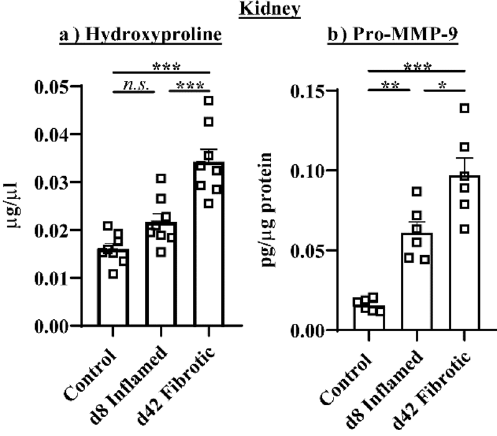
Figure 7. Repeated DSS cycles increased ( a ) hydroxyproline and ( b ) pro-MMP-9 concentrations in the kidney * P < 0.05, ** P < 0.01, *** P <